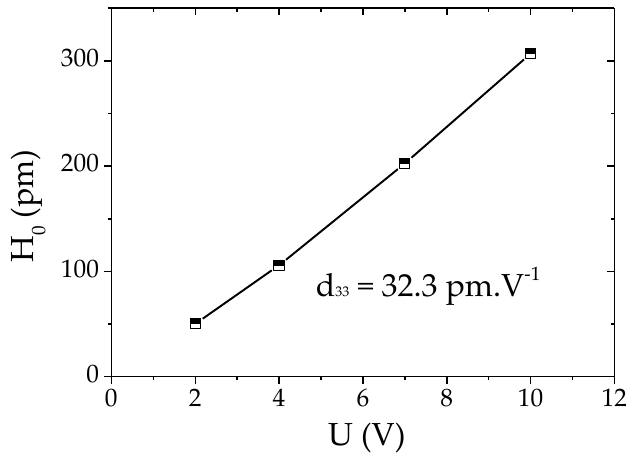
Figure 6. Static displacement (computed from vibrometer measurements) vs. applied voltage measured on one RS/PLA 2.5 thick sample.